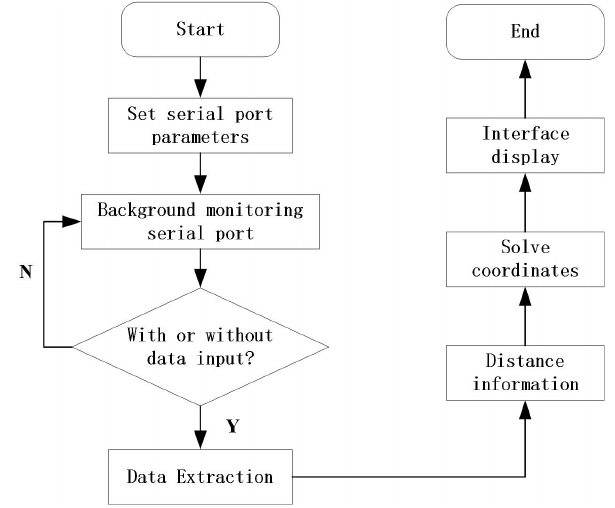
Figure 5. PC software flow chart of calculating.